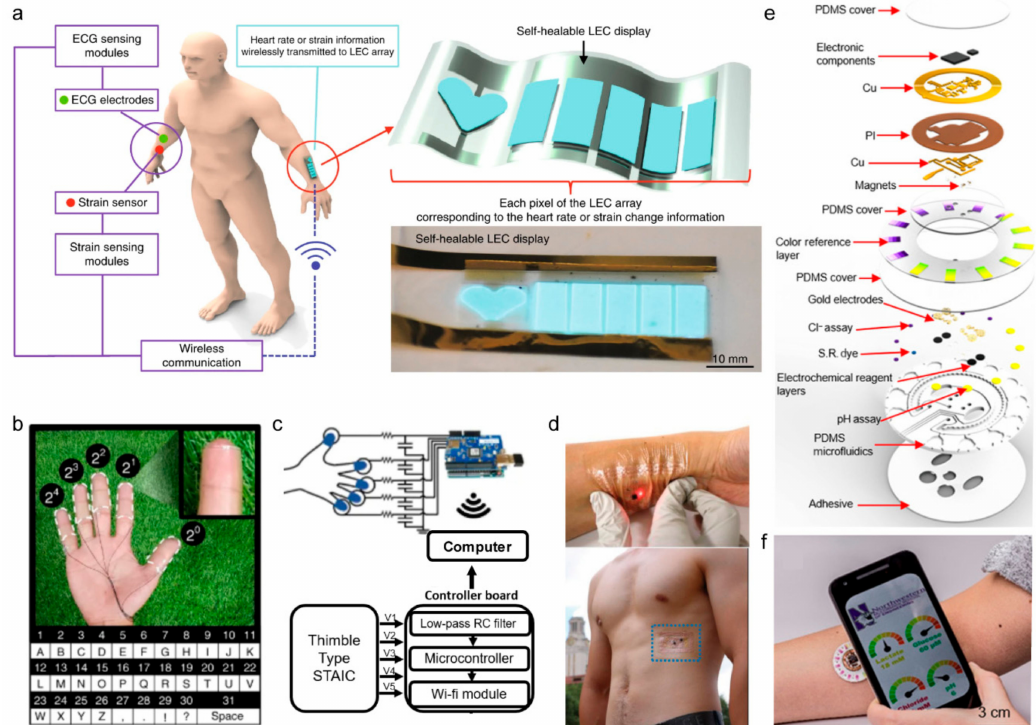
Figure 6. Electronic skins. ( a ) Overview of the system with sensors wirelessly communicating values to the display (Reproduced with permission [137]. Copyright 2018, Springer Nature). ( b ) Self-cleanable, transparent, and attachable ionic communicators were attached on the fingers and connected with wires to a controller board. A di ff erent order of a binary system was assigned to each finger, and the letters were pre-coded in the microcontroller (Reproduced with permission [138] Copyright 2018, Springer Nature). ( c ) Block diagram of the communicator based on STAICs. STAICs were connected to a controller board which contains an RC low-pass filter, a microcontroller, and a Wi-Fi module (Reproduced with permission [138] Copyright 2018, Springer Nature). ( d ) Top: A photo of the assembled ECG e-tattoo. Photos of a wireless e-tattoo with LED worn on the skin powered by a wireless NFC reader concealed beneath the white paper: compressed. Bottom: A picture of the battery-free ECG e-tattoo applied at the lower rib cage of a male subject (Reproduced with permission [53]. Copyright 2019, John Wiley and Sons). ( e ) Schematic illustrating the exploded view of the complete hybrid battery-free system. PI, polyimide; S.R., sweat rate (Reproduced under the terms of the CC BY-NC license [139]. Copyright 2019, the authors, published by The American Association for the Advancement of Science). ( f ) A phone interface that illustrates wireless communication and image acquisition (Reproduced under the terms of the CC BY-NC license [139]. Copyright 2019, the authors, published by The American Association for the Advancement of